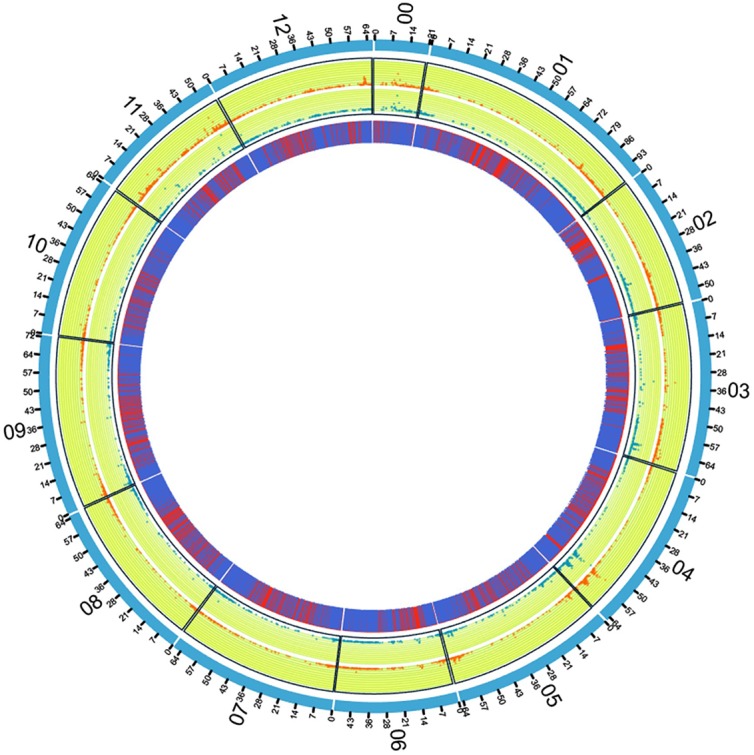
SNP distribution and density on the tomato genome in the two tomato varieties.The outer circle represents the tomato chromosomes; the inner circle graphically reports the distribution of transcribed regions (presence in blue, absence in red). The middle circles report the distribution and density of SNPs in our samples (blu dots: Docet; orange dots: Kiros). The height of each point relates to the SNP frequency in a 50 kb window.